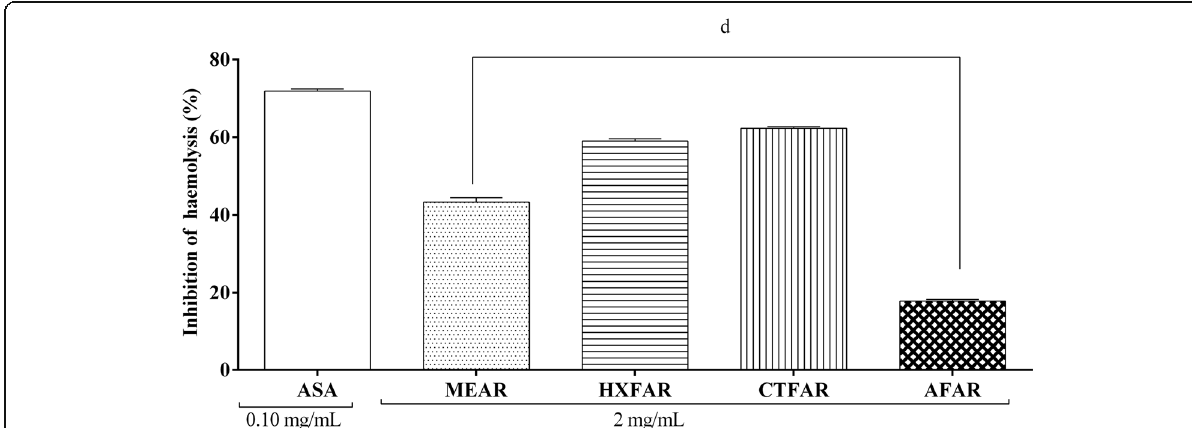
Fig. 1 Effect of different extracts of stem of Albizia richardiana on hypotonic solution-induced haemolysis of erythrocyte membrane. Values are represented in Mean ± SEM ( n = 3). d P < 0.0001 considered as statistically significant in comparison to positive control acetylsalicylic